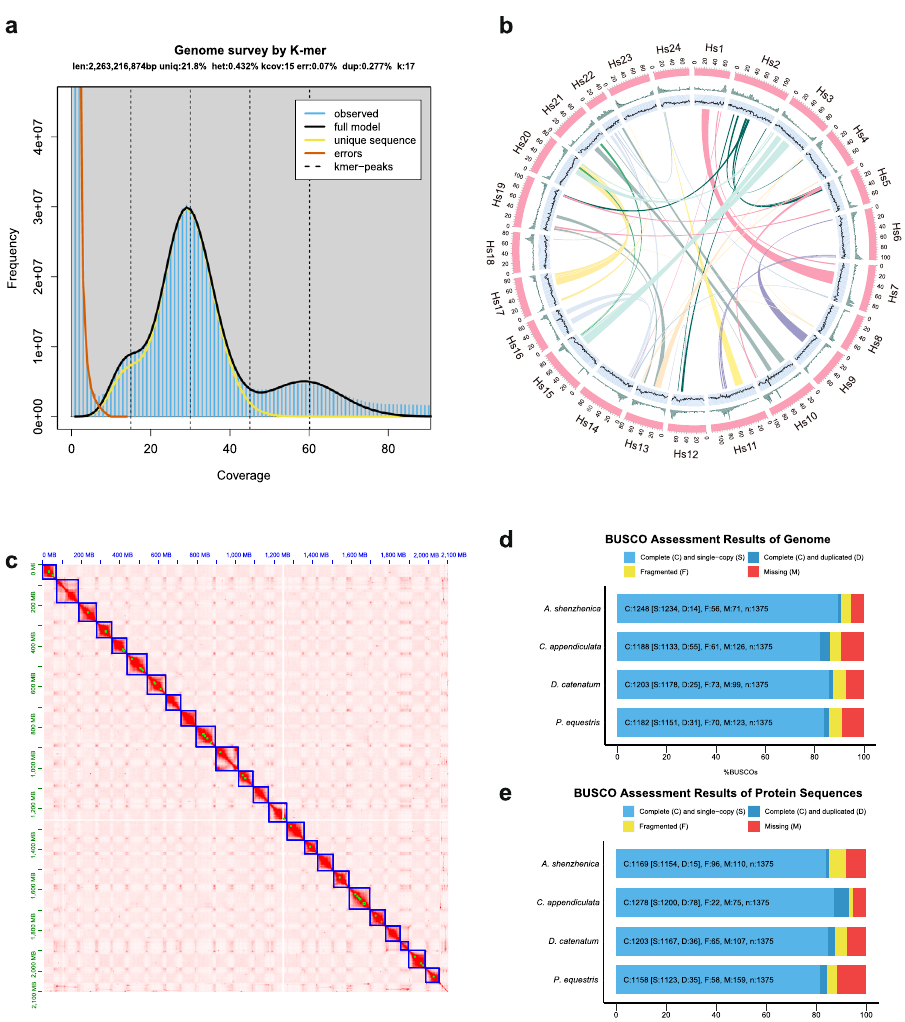
Fig. 1 Overview of C. appendiculata genome assembly. a K-mer analysis of C. appendiculata genome. b A circular representation of the C. appendiculata chromosomes. The colored bands summarize the density of chromosome length (Mb) (pink), gene numbers (green), GC content (black line), and collinearity individually. c Hi – C interaction heat map for the C. appendiculata genome. The blue box represents a chromosome. d BUSCO assessment of C. appendiculata, A. shenzhenica, D. catenatum , and P. equetris genome. e BUSCO assessment of C. appendiculata, A. shenzhenica, D. catenatum, and P. equetris protein